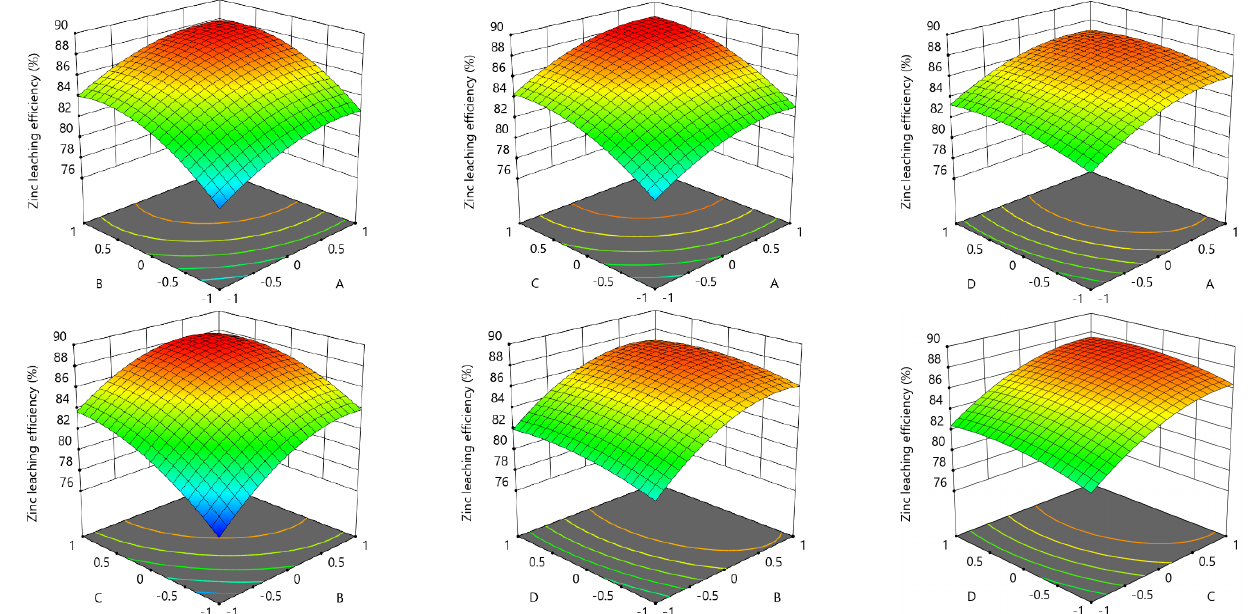
Figure 6. Response surface of the influence of various factors on zinc leaching efficiency.